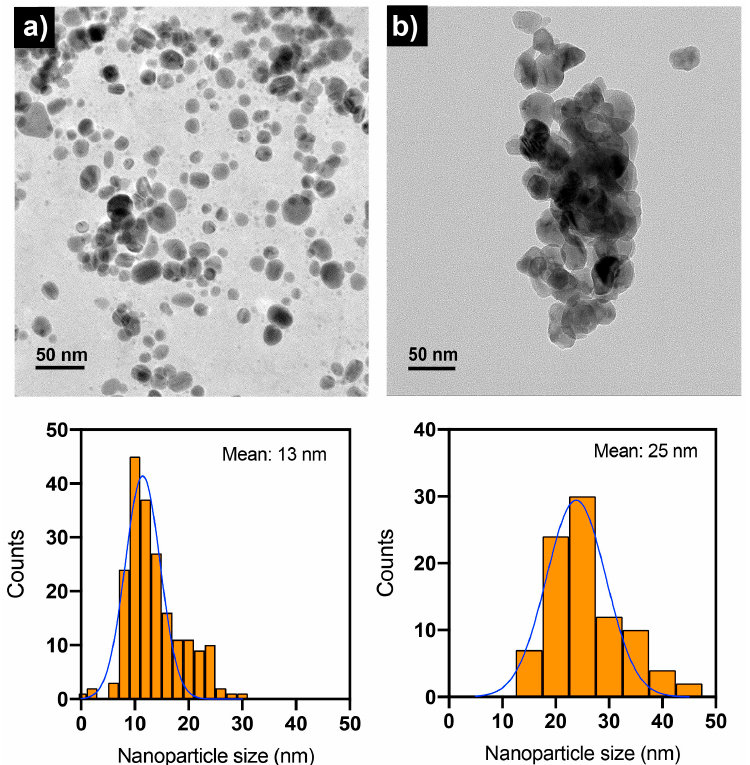
Figure 5. TEM images and nanoparticle size distribution histograms of Ag NPs ( a ) and CS-Ag NPs ( b ) synthesized using extracts of unencapsulated fungal biomass and chitosan-immobilized biomass of S. hirsutum , respectively. The “as-synthesized” nanoparticle suspensions were employed in TEM analysis with a pH near 10.